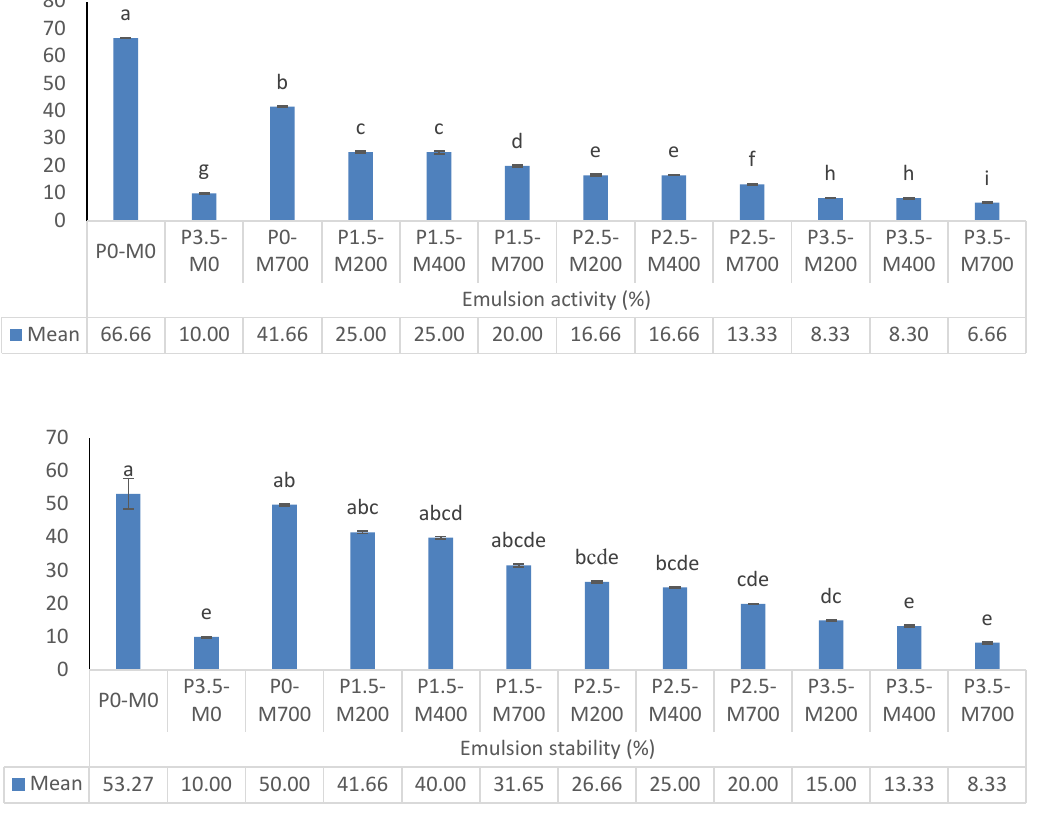
Figure 3. The effect of phosphorylation (%) and microwave power (W) on emulsion activity and stability of egg white powder. Means ( n = 3) with different letters in each column indicate significant difference ( p < 0.05).